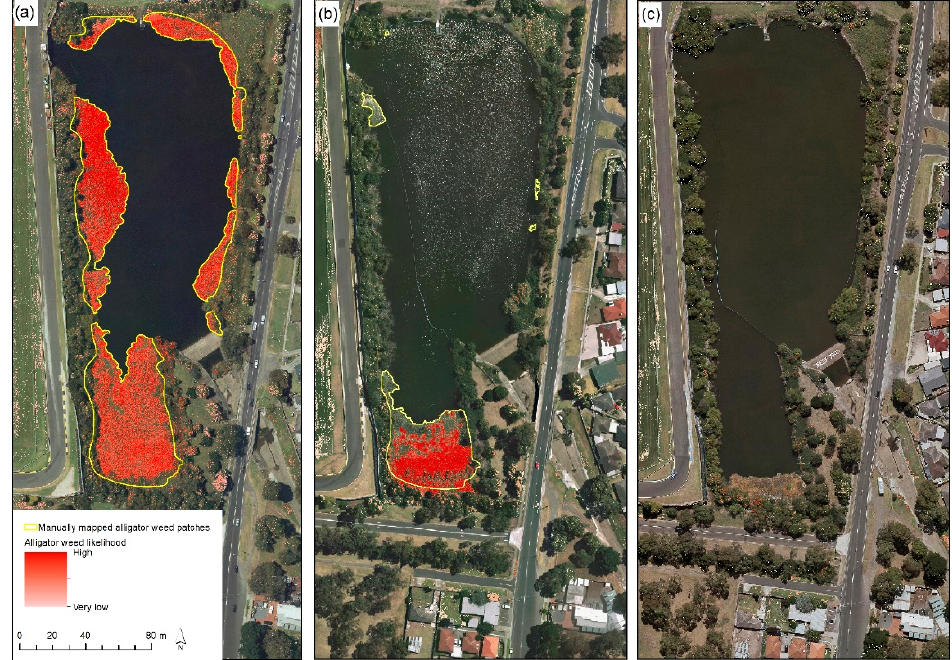
Figure 8. Alligator weed infestation declining due to management and removal works in ( a ) 2010, ( b ) 2013 and ( c ) 2016.